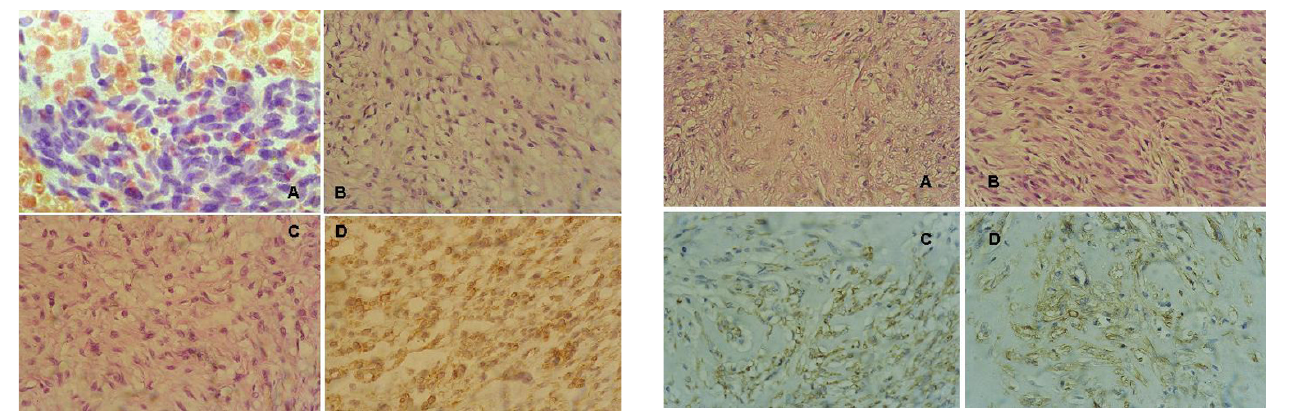
myofibroblastoma Figure 2 myofibroblastoma . (a) Most of the tumor is formed of hyalinized collagen bundles surrounded by spindle cells, H&E × 400. (b) Cellular area formed of palissading spindle cells, H&E × 400. (c) Staining of spindle and oval cells is more pro- nounced in the lower right part, CD34 IHC, DAB, Hx × 400. (d) Focal area of spindle and oval cells positive for SMA, IHC, DAB, Hx ×400. See additional files 5, 6, 7, 8 for higher reso- lution